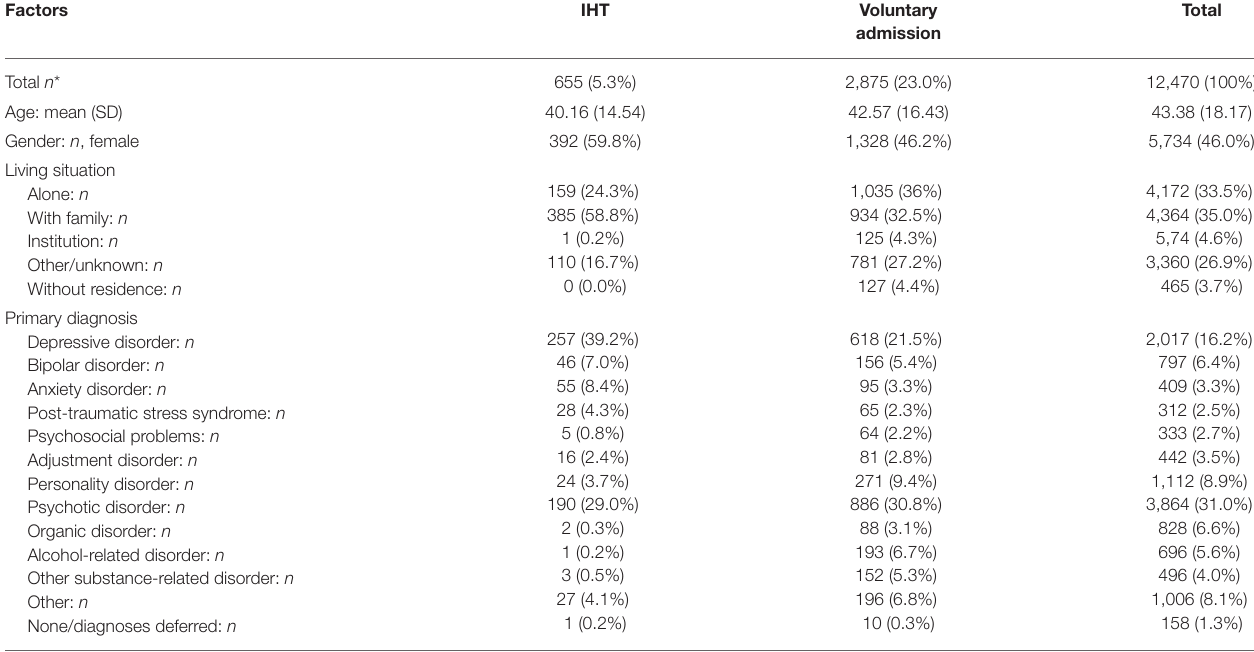
TABLE 1 | Characteristics of patients assessed by the psychiatric emergency services.